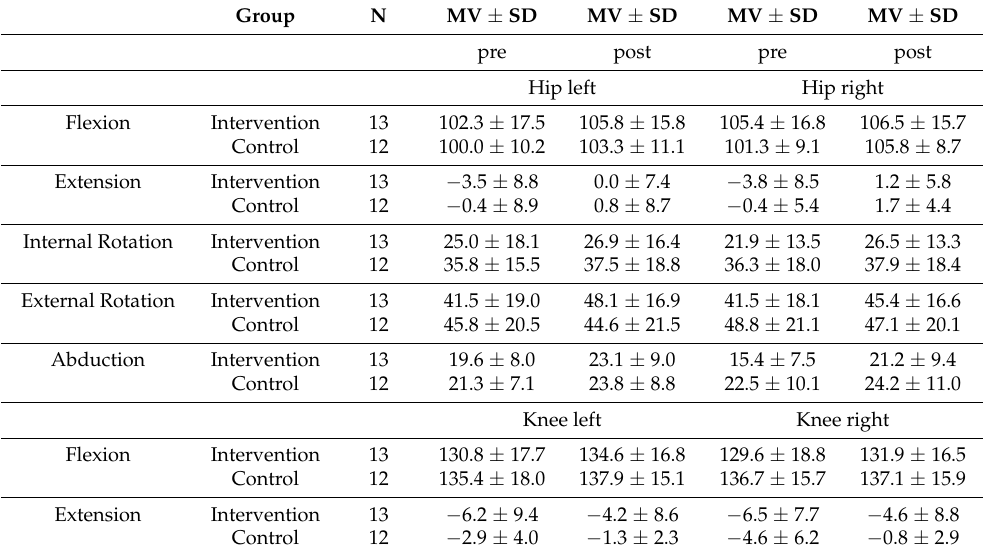
Table 8. Results of the measurement of the passive range of motion of the lower